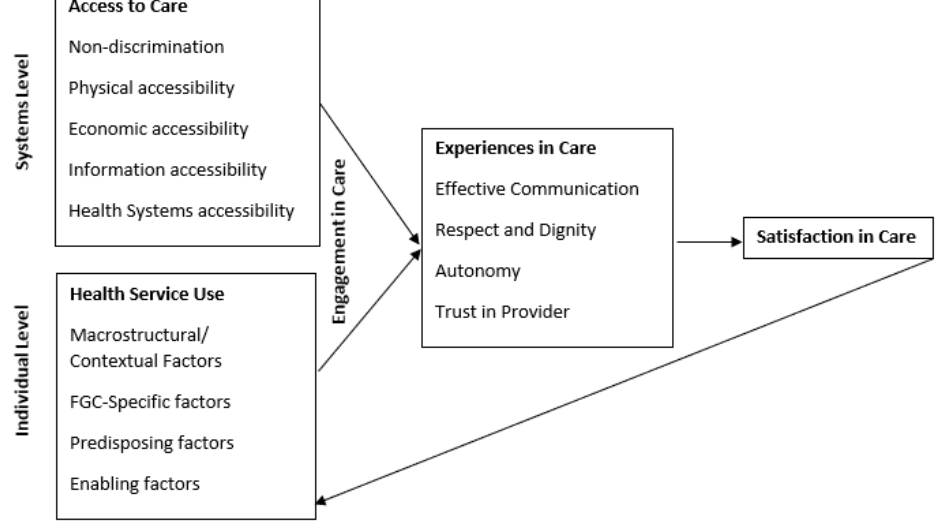
Figure 1. Conceptual model of factors associated with satisfaction in FGC-related care.